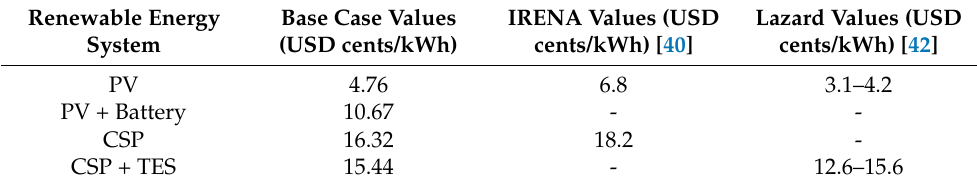
Table 20. Comparison of the LCOE (base case values) with the